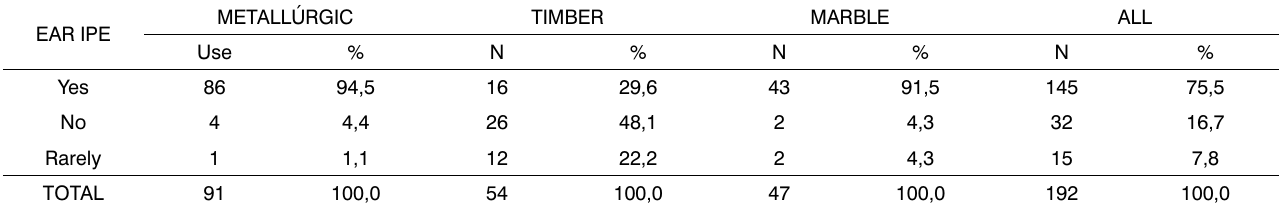
Table 1. Sample data collected during the patient interview according to the use of ear IPE and the industry, Distrito Federal, 2006-2007.